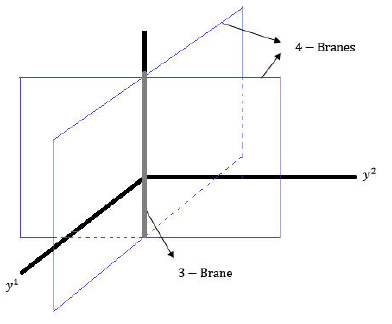
Figure 3 . Intersecting branes model with two transverse extra